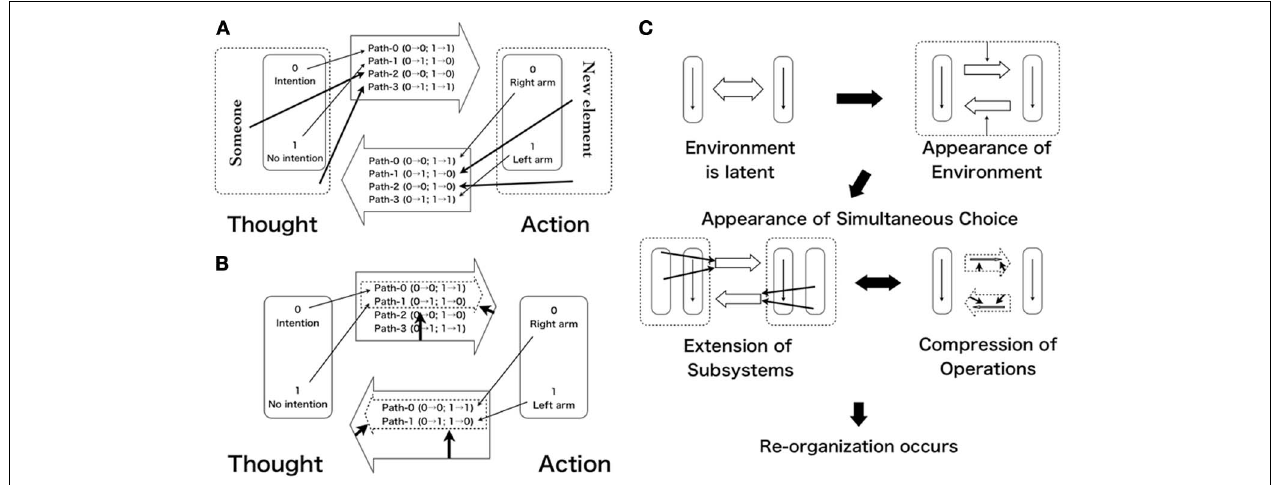
FIGURE 5 | (A) Extension of thought/action set. (B) Compression of path set. (C) Development of observational